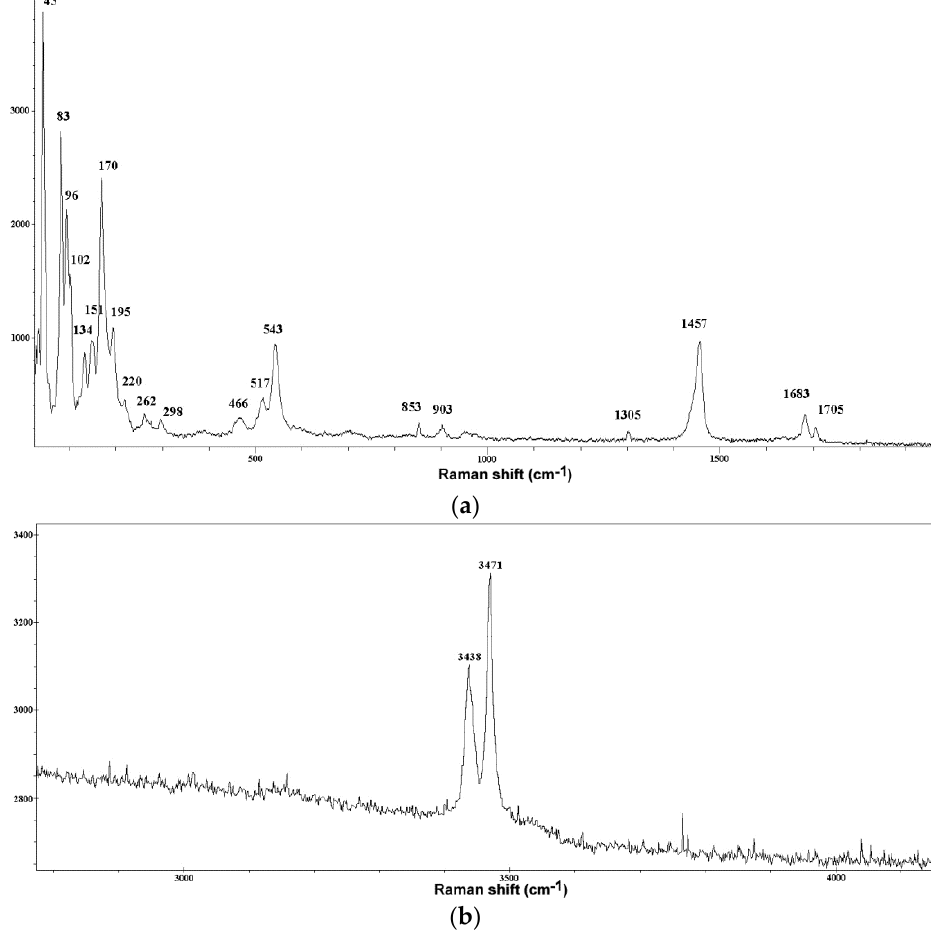
Figure 2. Micro-Raman spectrum of fiemmeite. ( a ) Oxalate and lattice mode bands; ( b ) hydrogen bond bands.